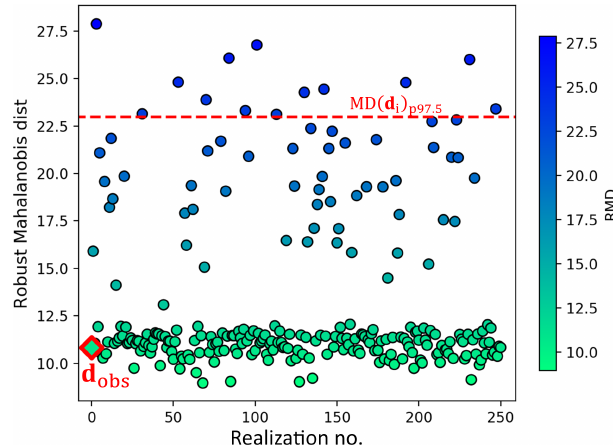
Figure 8. Prior falsification using robust Mahalanobis distance (RMD). Circle dots represent the calculated RMD for data variable samples. The red square is the RMD for borehole observations. The red dashed line is the 97.5 percentile of the chi-squared distributed